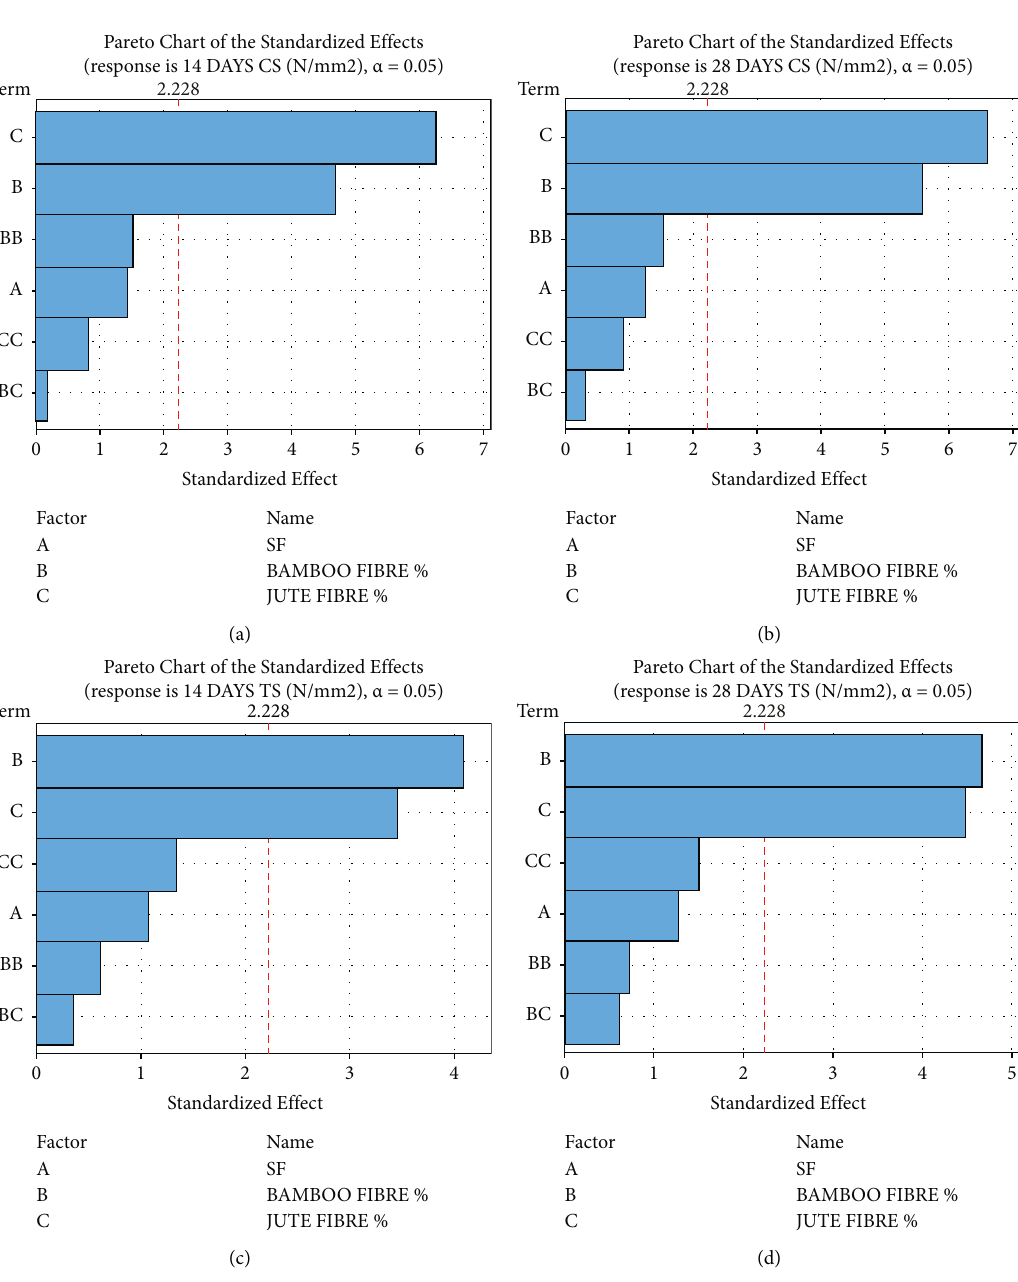
, (b) fcs , (c) fSTS 14 28